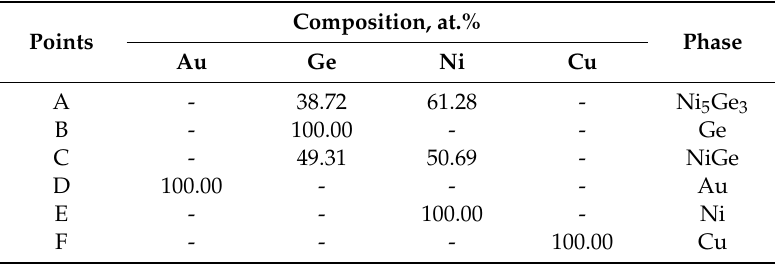
Figure 6. Scanning electron microscopy (SEM) micrograph of Au-12Ge/Cu interface after soldering: ( a ) 1000 × ; ( b ) 5000 × . ( a ) 1000×; ( b ) 5000×. Table 2. The EDS results of Figure Table 2. The EDS results of Figure 6.